Question: Sum up the contents of this chart in one sentence.
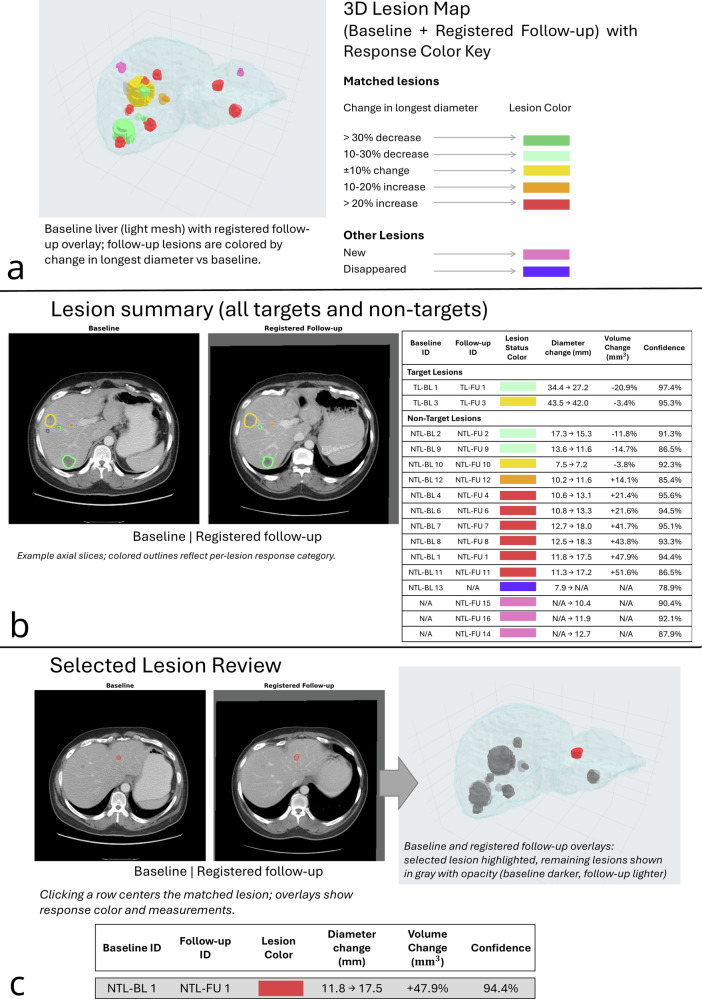
Answer: Interactive review for longitudinal lesion tracking. a Three-dimensional (3D) overview with baseline liver as a light mesh and registered follow-up overlaid; follow-up lesions are color-coded by per-lesion change (ranges shown in the panel legend). b Synchronized two-dimensional (2D) review displays baseline and registered follow-up axial images; the accompanying table lists all lesions (targets and non-targets) with identifiers, response color, diameter/volume change, and a confidence score (thresholds indicated in the panel). c Selected-lesion view: choosing a lesion (matched pair) centers the two slices and highlights the lesion in color; a compact metrics strip reports the longest diameter and volume at both time points with % change, and a 3D locator shows its position while other lesions are grayed